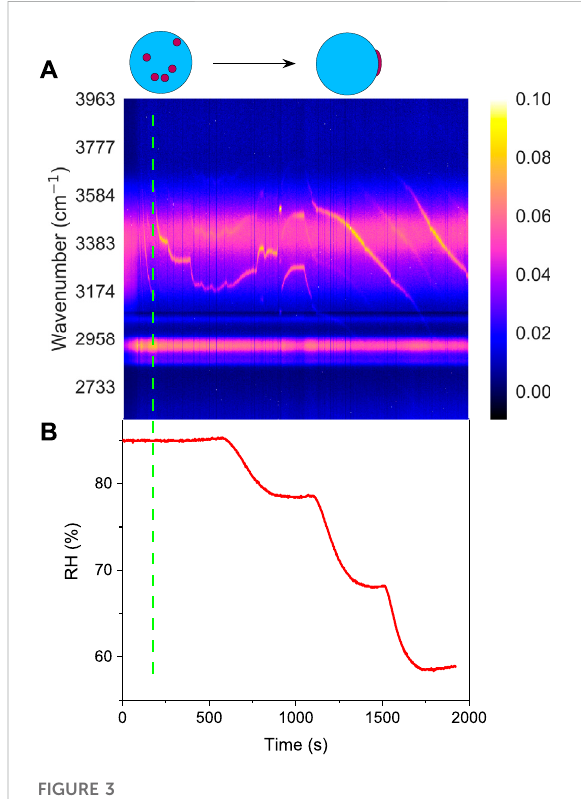
FIGURE 3 Liquid-liquid phase separation of aqueous oleic acid/sodium chloride (OA-I). (A) time-resolved Raman spectra and schematic diagram of phase separation, the bright trend dots indicate the position evolution of the detectable peaks (i.e., the WGMs shown in Figure 2). (B) RH variation with time in the trapping chamberduring thedehumidifyingprocess. Thegreendashedline indicates the moment when the random motion of inclusions in the droplet stopped and culminated in a stable partially-engulfed